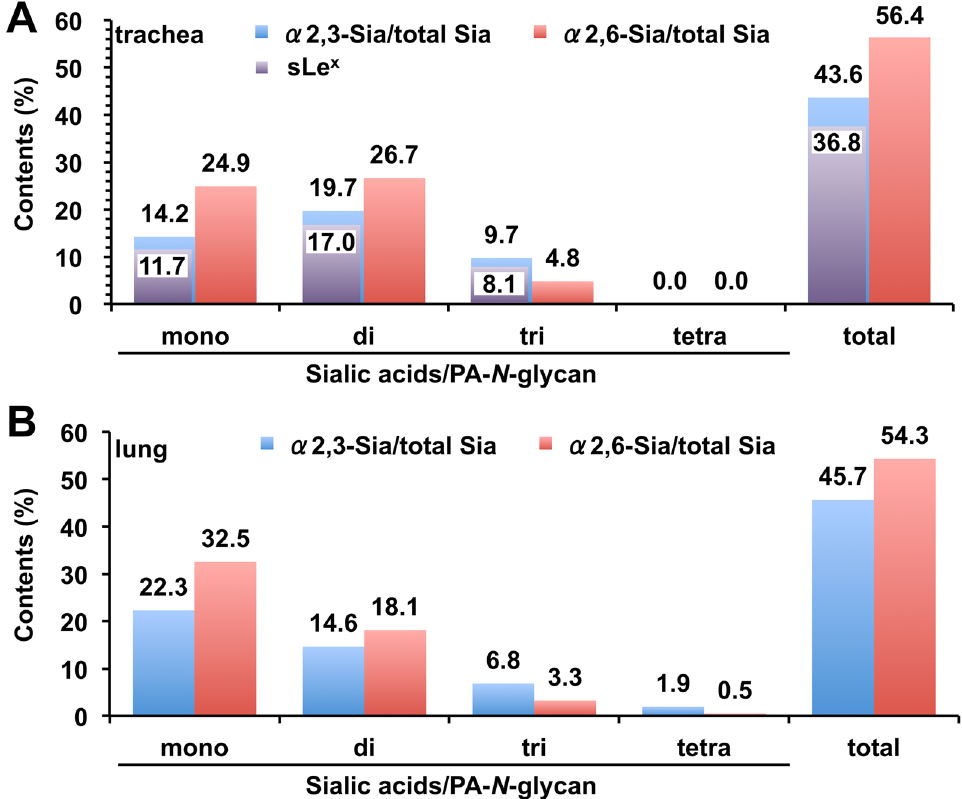
Figure 5. Relative content of α2,3- and α2,6-Sia in sialylated N -glycans from chicken trachea ( A ) and lung ( B ), estimated using the SALSA method. The proportions of α2,3- and α2,6-Sia in mono-, di-, tri-, or tetra-sialylated glycans, as well as in total glycans from the tissues, were calculated based on the results of LC–MS and MS/MS analyses of PA- N -glycans after SALSA, as indicated in Supplementary Table S2. In the results of trachea, the relative content of sLe x is shown as purple bars ( A